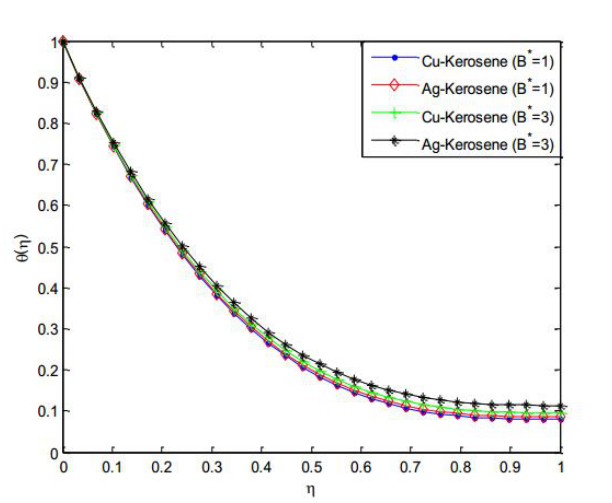
Figure 19. Effect of non-uniform heat source/sink parameter (B*) on the fluid temperature distribution